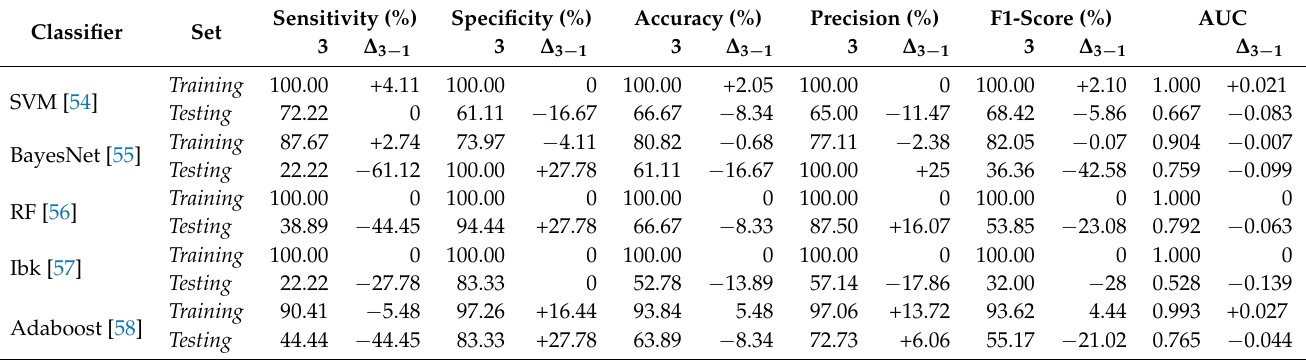
Table 3. Results obtained considering poisoned voice signals in the training set and clean signals in the testing set ( scenario 3 ).